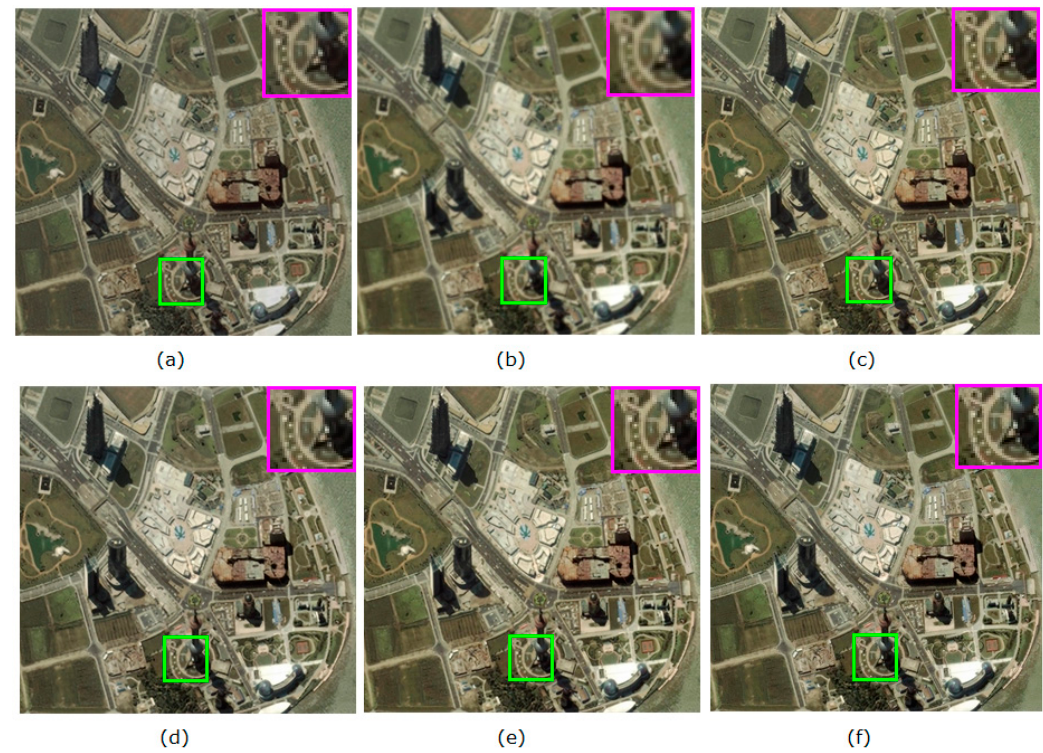
Figure 10. Visual quality comparison of speckle removal of the real color SAR image. ( a ) SAR-BM3D; ( b ) SAR-CNN; ( c ) ID-CNN; ( d ) SAR-UNet; ( e ) CCNN; ( f ) CCNN+.